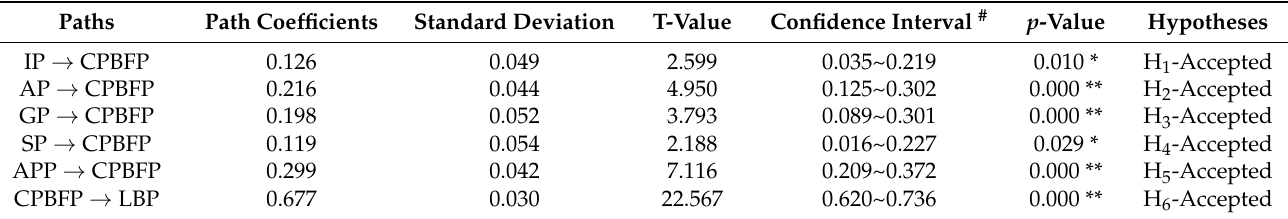
Table 3. Path coefficients of the structural equation